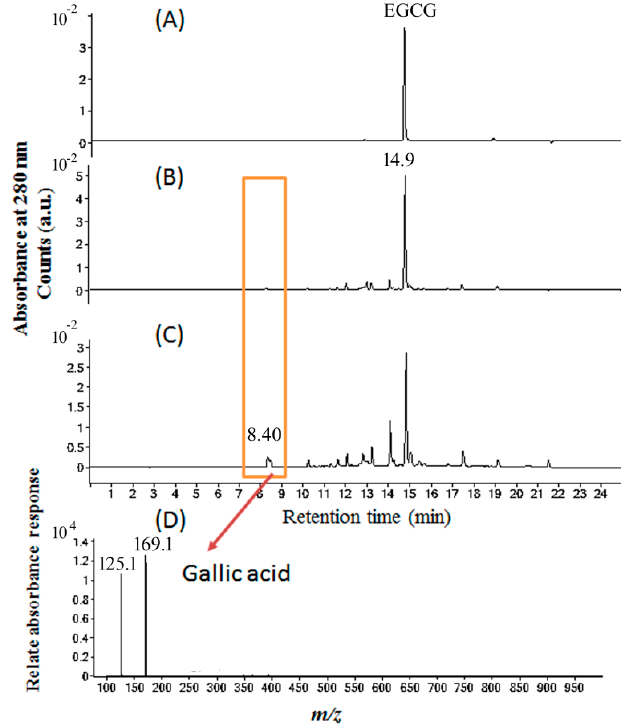
Figure 8. Chromatograms of HPLC–photodiode-array detector (HPLC–DAD) analyses of ( A ) EGCG in H 2 O, ( B ) EGCG in phosphate buffer solution (pH 8), ( C ) EGCG in phosphate buffer solution (pH 8) treated with blue light illumination at 2.0 mW/cm 2 for 2 h, and ( D ) electrospray ionization mass spectra of the photoreaction products from the EGCG in ( C ) at 8.4 min.